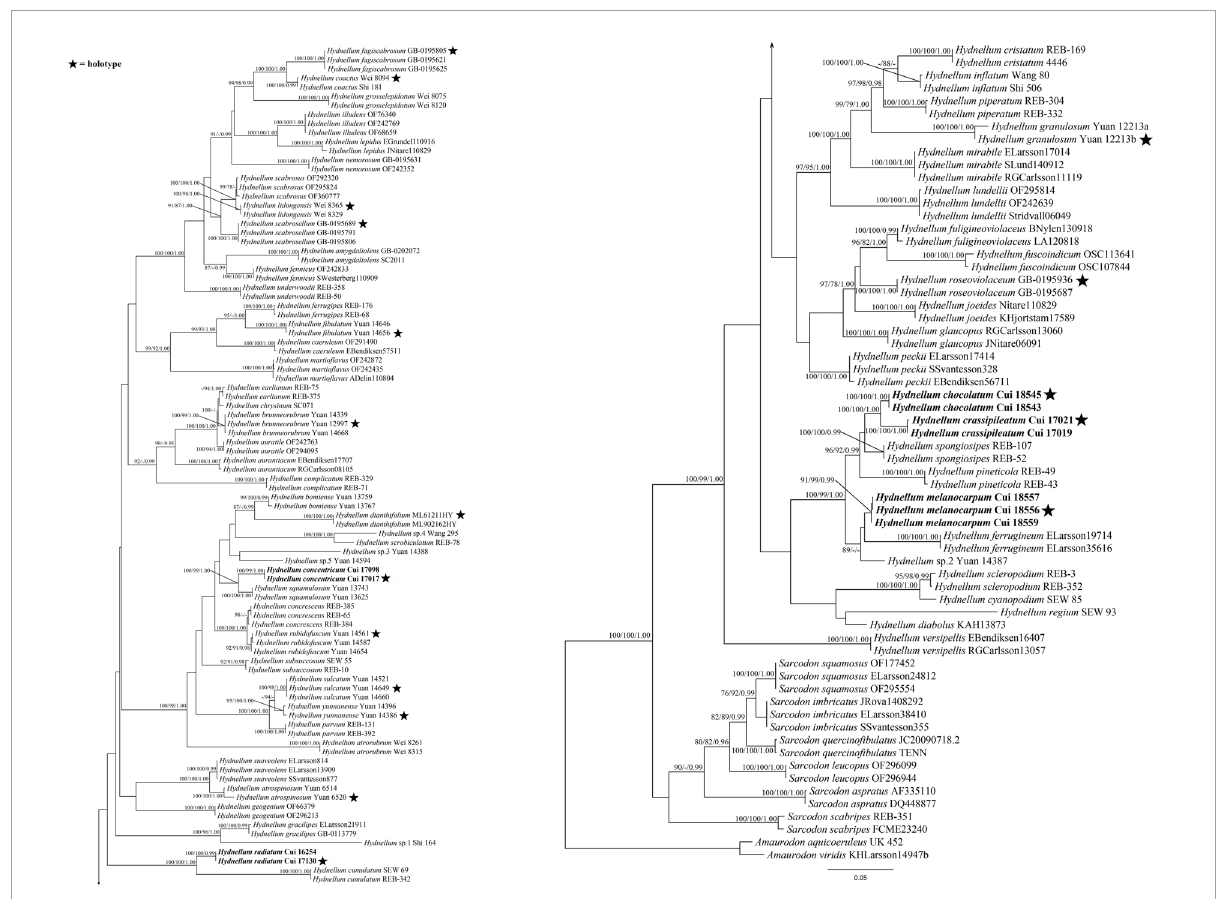
FIGURE2 Maximum likelihood tree of the Hydnellum species based on the combined ITS + nLSU + nSSU + RPB2 sequences data. Branches are labeled with parsimony bootstrap values equal to or higher than 75%, ML bootstrap values equal to or higher than 75%, and Bayesian posterior probabilities equal to or higher than 0.95. Bold names = New